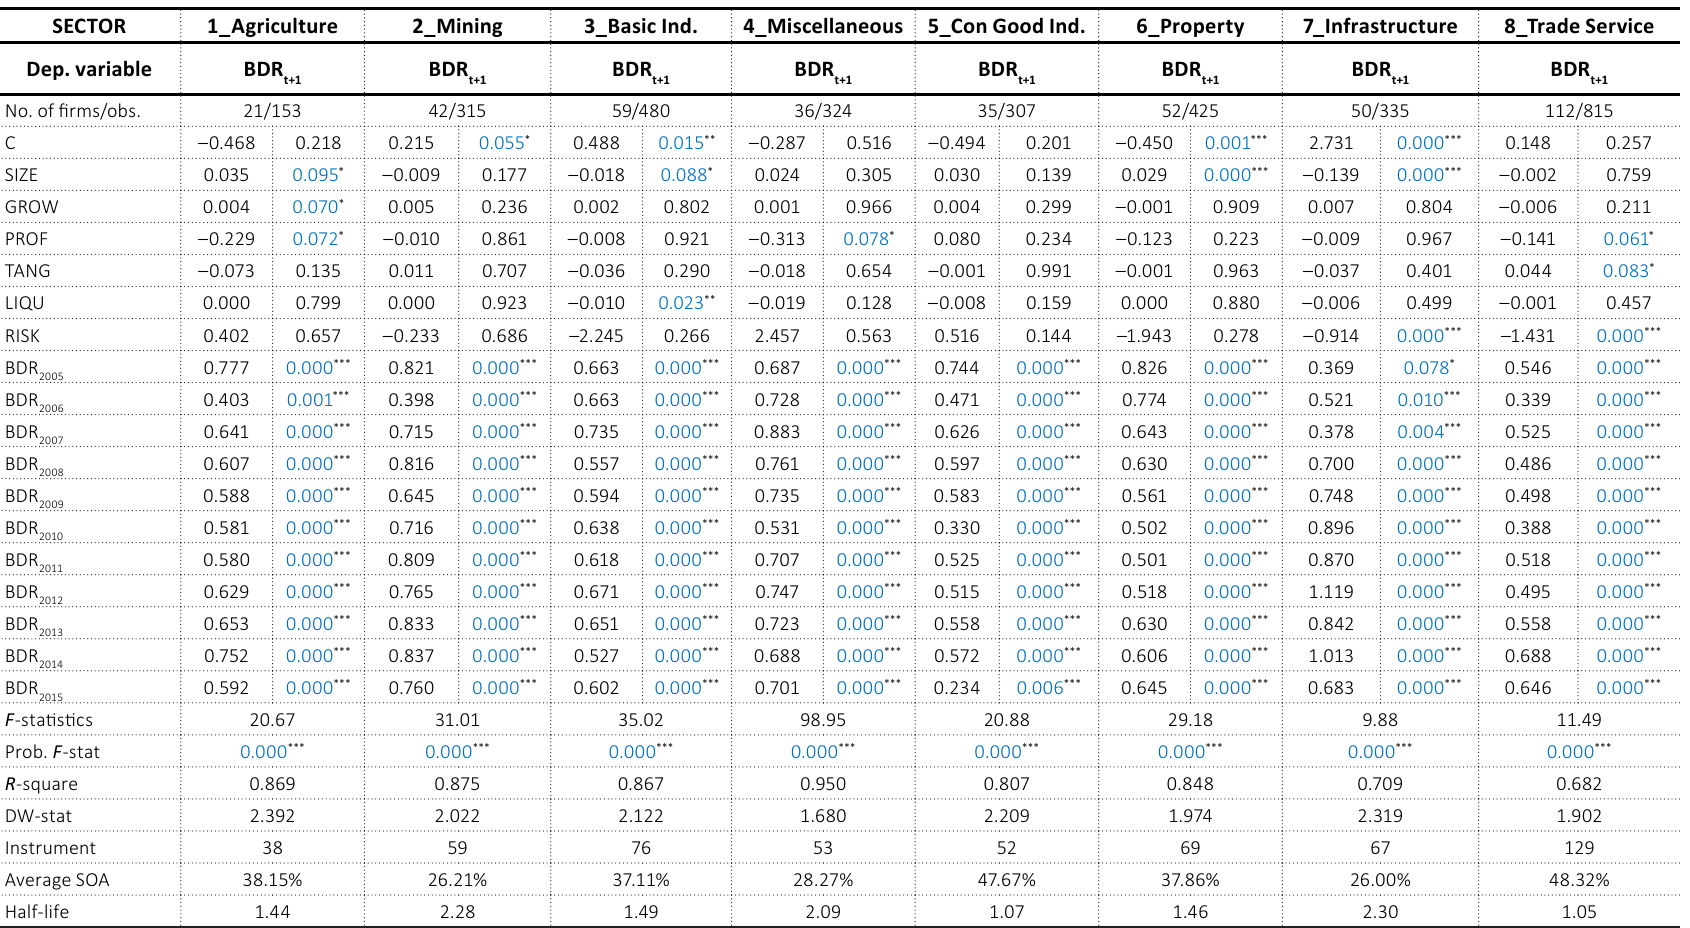
Table 5. Across sectors analysis using firm-specific determinants